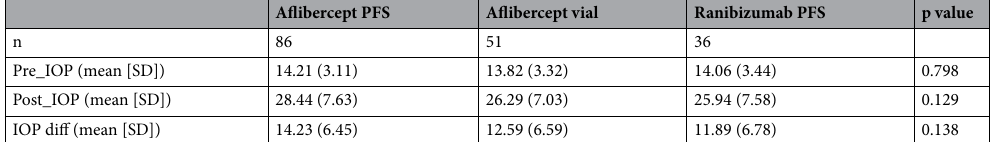
Table 2. IOP characteristics pre- and postoperatively in the three patient groups. IOP Diff Intraocular pressure differences, PFS prefilled syringes, SD standard deviation.